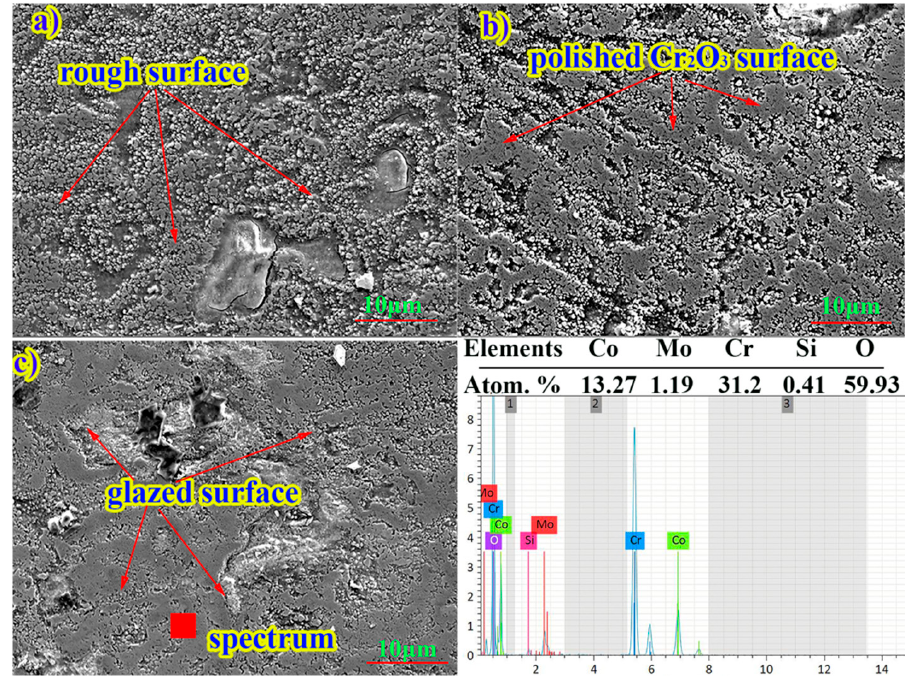
Figure 16. SEM images of the worn surfaces of CoMoCrSi coating annealed for 3 h with a distance of 300 m ( a ), 500 m ( b ), and 1000 m ( c ).